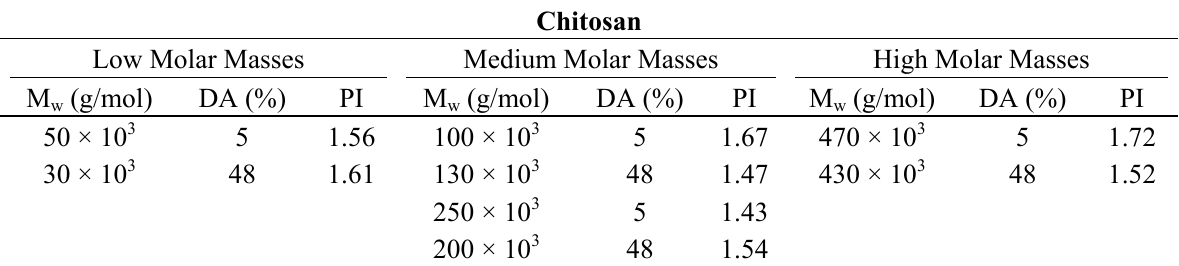
Table 1. Physicochemical characteristics of chitosan determined by SEC and NMR. Chitosan